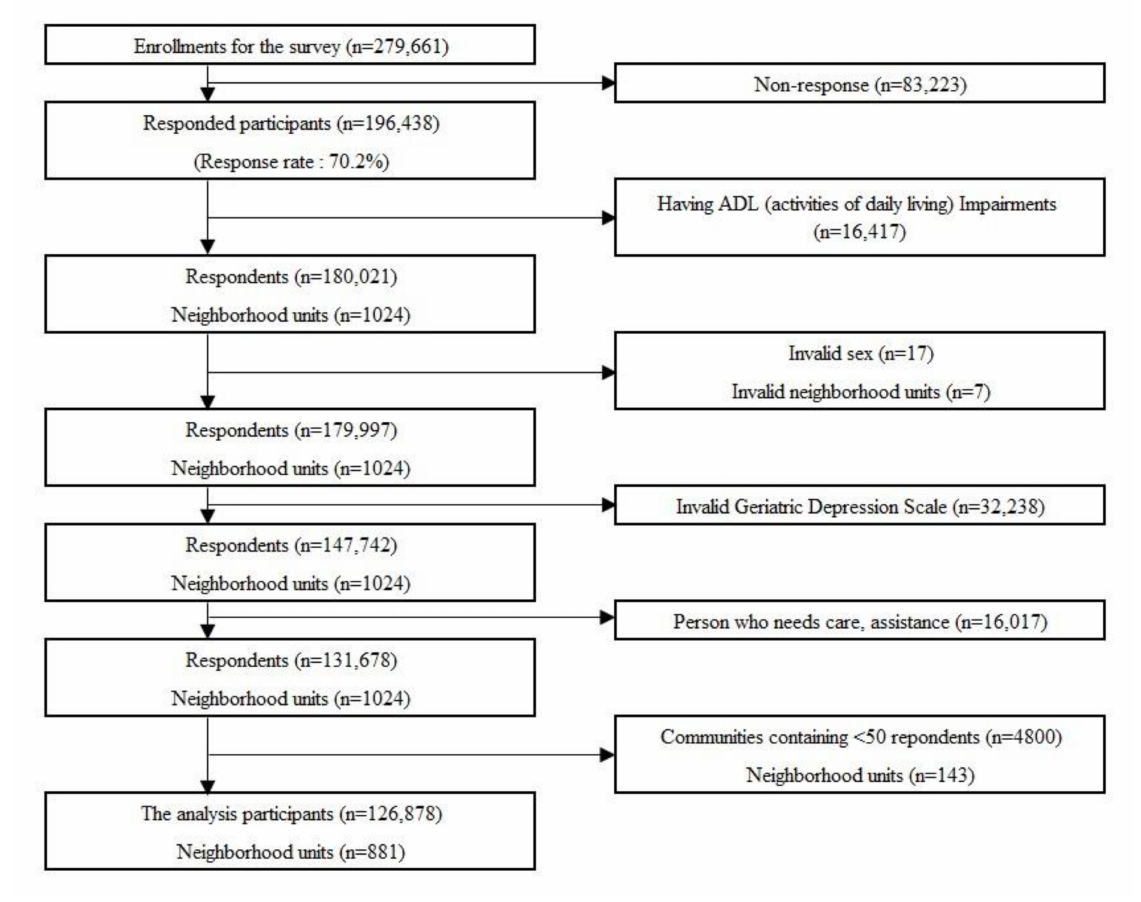
Figure 3. Flow chart of the survey participants. Table 1. Participants’ descriptive